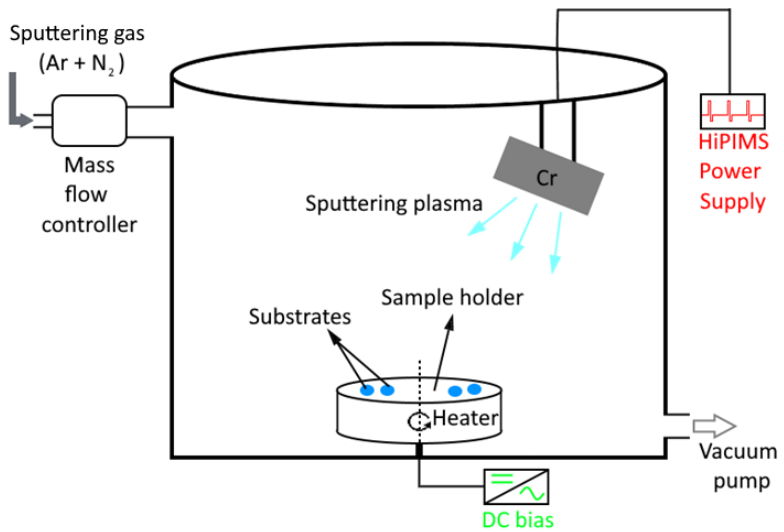
Figure 1. The general schematic diagram explaining the deposition chamber.